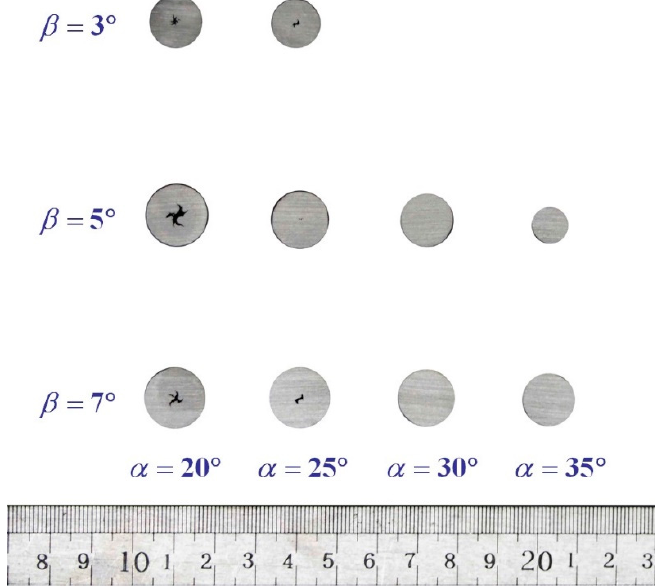
Figure 7. Central quality at position 5 of different parameters.